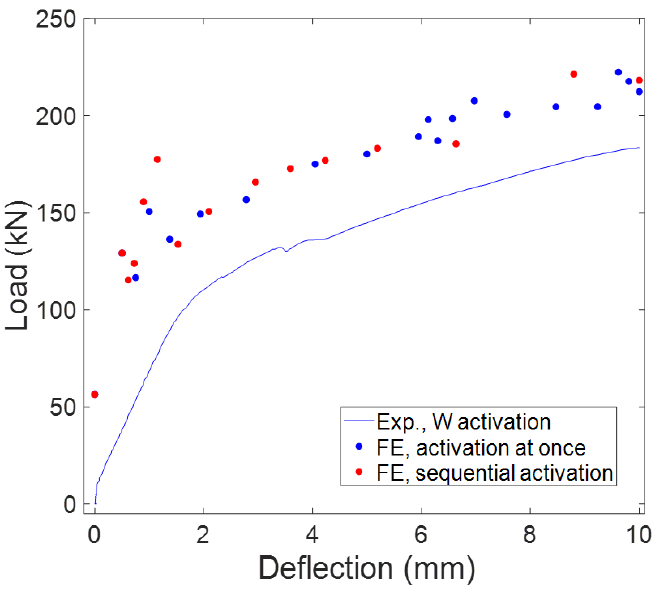
Figure 10. Comparison of experimental results and FE simulations for bending load-deflection responses of RC beams with 5 SMA bars, activated sequentially and at once.